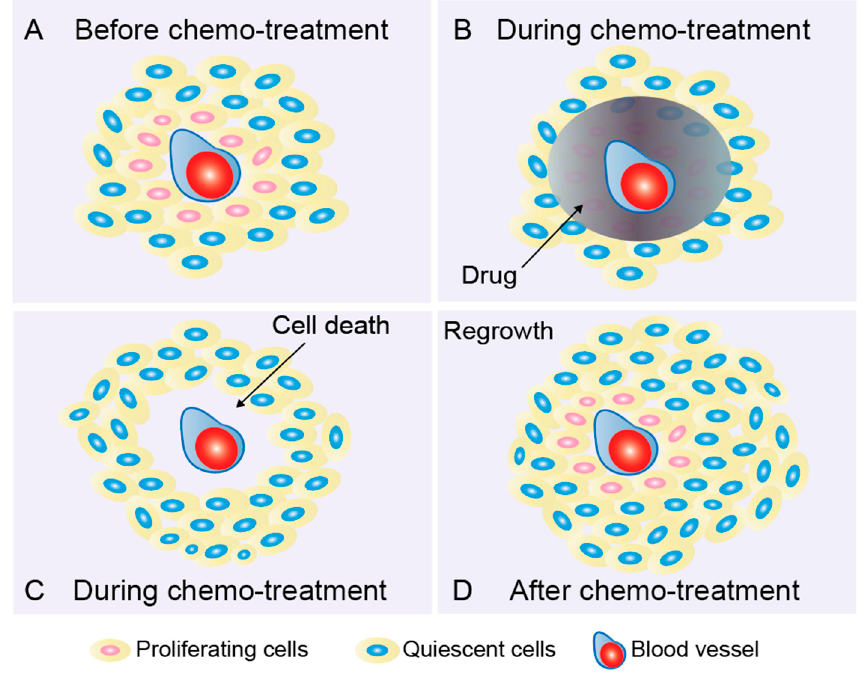
Figure 1. Quiescent cancer cells lead to drug resistance and tumor recurrence. ( A ) Quiescent cancer cells (QCC, “dormant”, slow-proliferating, nonproliferating, and cell-cycle-inactive) located in areas far from blood vessels are considered to be an important cause of treatment failure in solid tumors. QCCs proliferate slowly and are insensitive to cell-cycle-active anticancer drugs. During the cycle of treatment, proliferating cells (red) sufficiently exposed to the drug ( B ) are removed; however, QCCs (blue) that are not properly exposed to the drug and inherently treatment-insensitive are spared ( C ). These QCCs are able to repopulate between treatment cycles when microenvironments are favorable ( D ). This process is defined as tumor recurrence or relapse. It has been observed that, under favorable conditions, tumors enriched in chemoresistant QCCs recur significantly earlier than tumors bearing fewer QCCs